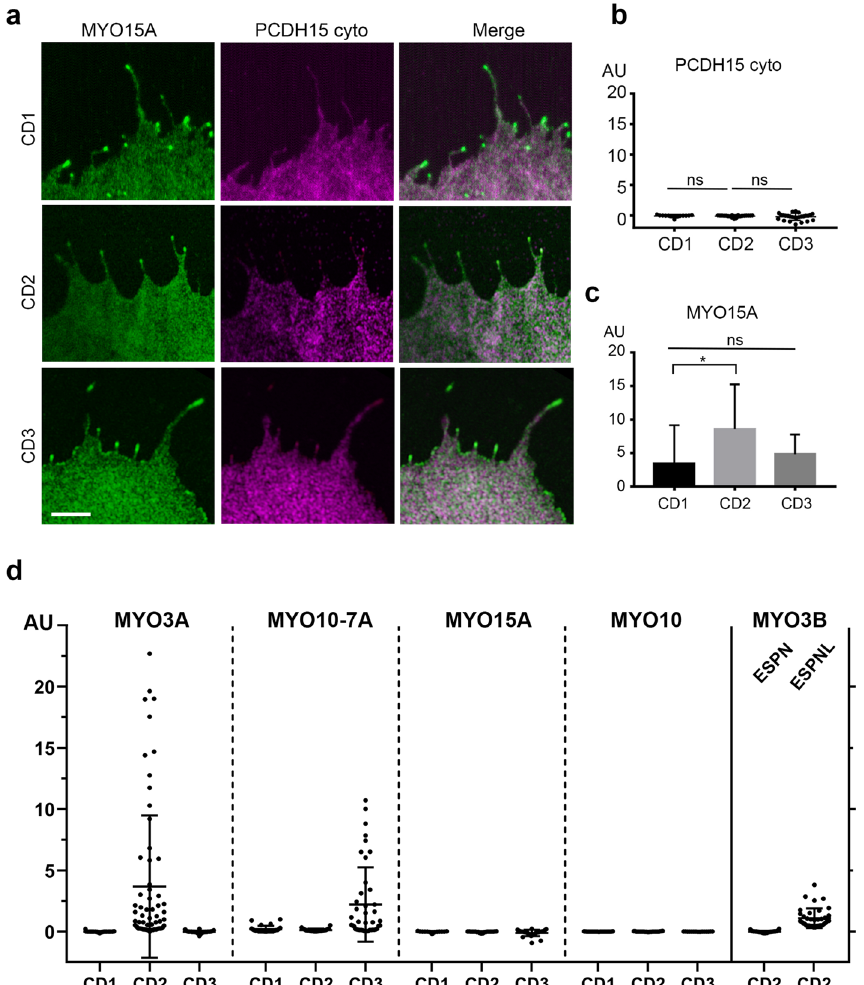
Figure 5. MYO15A does not transport PCDH15 to the tips of filopodia. ( a ) Confocal images of COS7 cells expressing MYO15A (green) and cyto PCDH15-CD1, -CD2 or -CD3 (magenta). ( b ) None of the PCDH15 isoforms showed a significantly tip-to-shaft ratio when co-expressed with MYO15A. ( c ) MYO15A exhibit a slightly higher enrichment at the filopodia tips when co-transfected with cyto PCDH15-CD2 when compared to -CD1 or -CD3. ( d ) Summary of the tip-to-shaft ratio of PCDH15 isoforms when expressed with MYO3A, MYO10-MYO7A, MYO15A, MYO10 and MYO3B in the presence of ESPN1 or ESPNL. Each dot in b and d represents one filopodia. Number of filopodia n = 13–66. One-way ANOVA analysis was performed with Dunnett’s multiple comparisons test. Level of significance was determined based on the p value (n.s p > 0.05, *p < 0.05, **p < 0.01, ***p < 0.001, ****p < 0.0001). Scale bar = 2